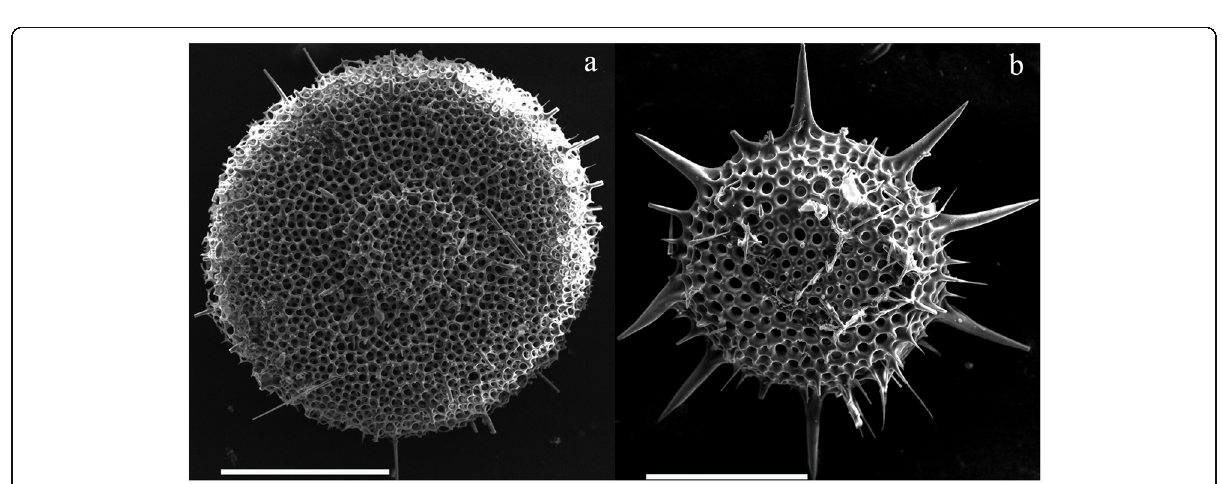
Fig. 3 Scanning electron microscope photos of a D188 and b D397. The scale bar in the bottom of photo represents 100 μ